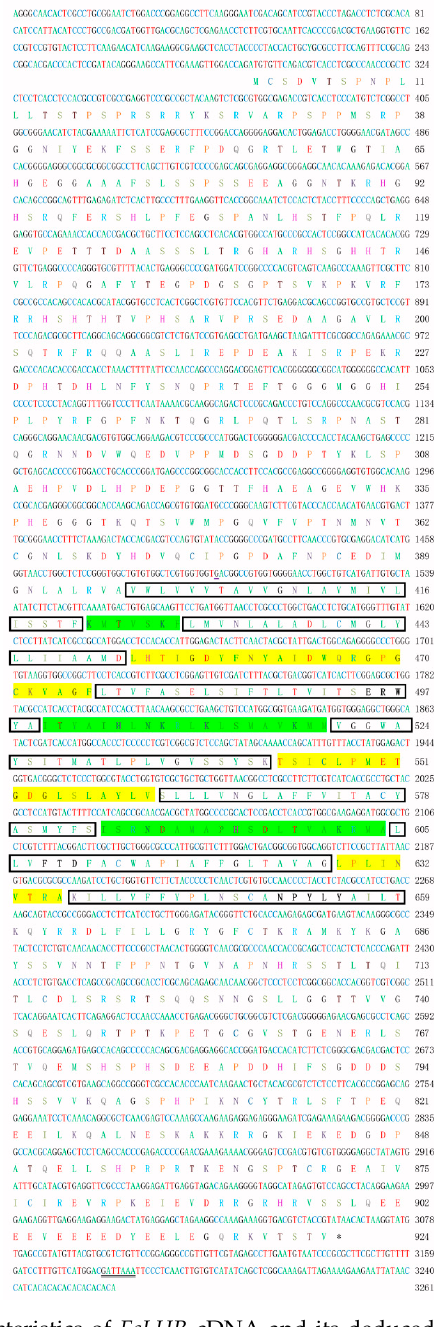
Figure 1. Molecular characteristics of EsLHR cDNA and its deduced peptide. The box indicates seven transmembrane helix regions; the green and yellow shadow highlight the intracellular, and the extracellular loop, respectively; the black font represent the special conserved signal sequence of G-protein coupled receptor (GPCR) family; the double underlined ATTAAA indicates a potential polyadenylation signal; the star marks the stop codon.